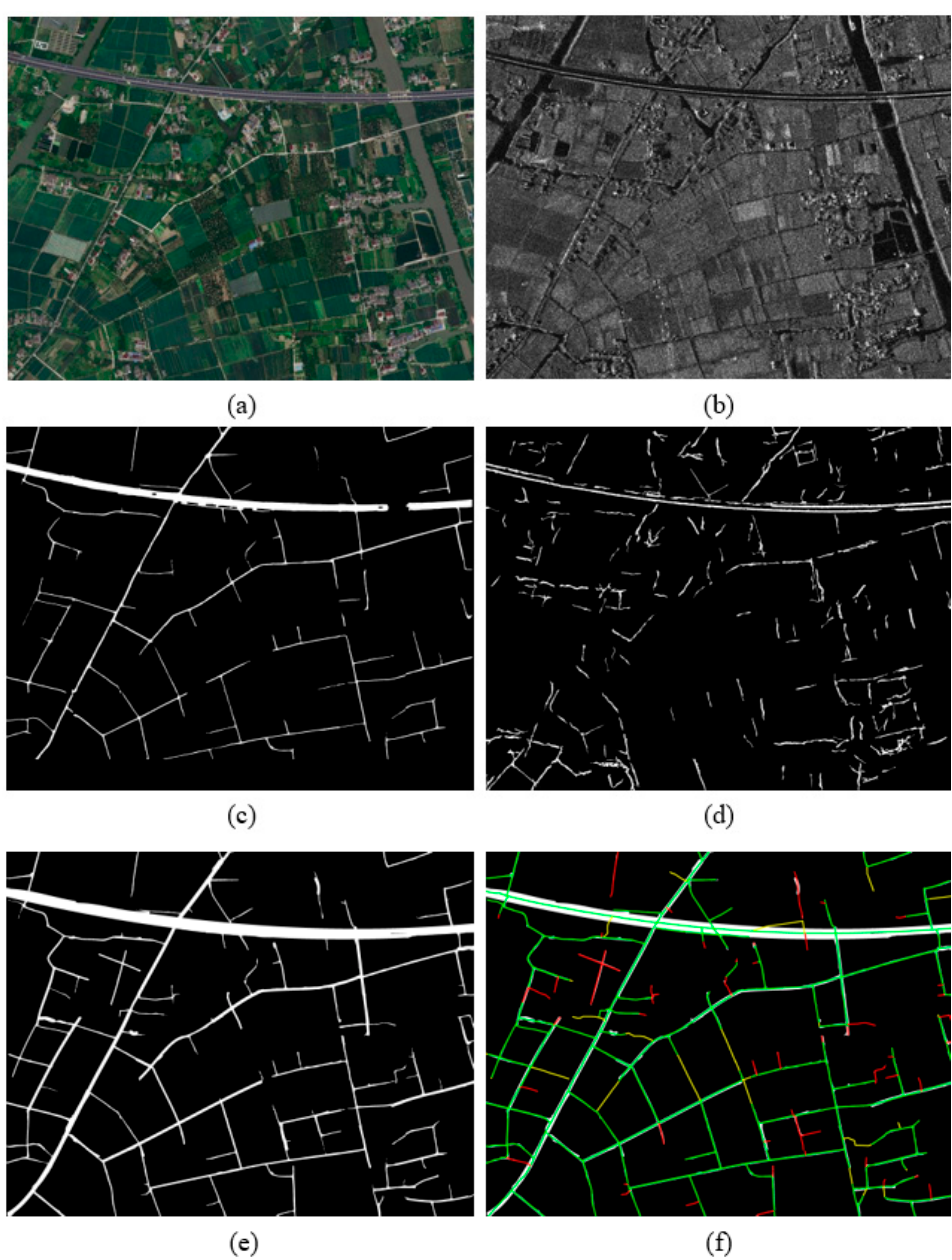
Figure 24. Tested data Area 2. Optical and SAR remote sensing images and road extraction results in the Chongzhou area. ( a ) Worldview-2 optical remote sensing image; ( b ) TerraSAR-X remote sensing image; ( c ) road extraction results of optical remote sensing image; ( d ) road extraction results from SAR remote sensing images; ( e ) road fusion extraction results of optical and SAR images; ( f ) ground truth and marking results of road fusion extraction results (green refers to the correctly extracted road, red refers to the incorrectly extracted road, and yellow refers to the omitted real road).